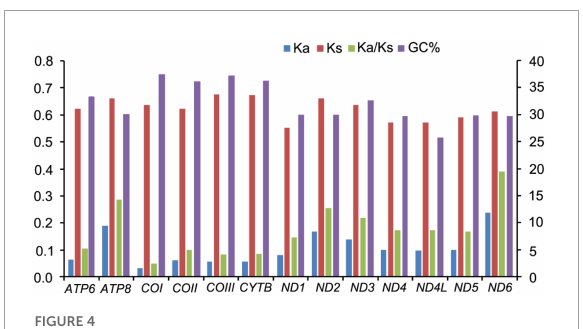
FIGURE4 Evolutionary rates of 13 protein-coding genes in the mitochondrial genomes of six peltoperlid species. The left Y-axis provides the substitution rate of the mitochondrial gene, while the right Y-axis provides the G + C